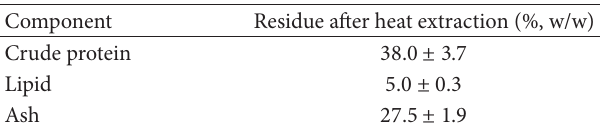
Table 2: Chemical properties of shrimp head residue after heat